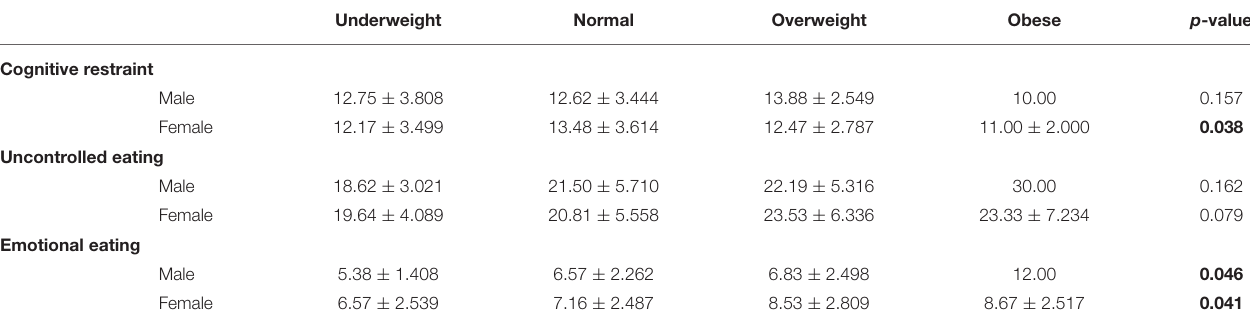
TABLE 5 | Association between eating habits and categorized BMI in males and females. Underweight Normal Overweight Obese p -value Cognitive